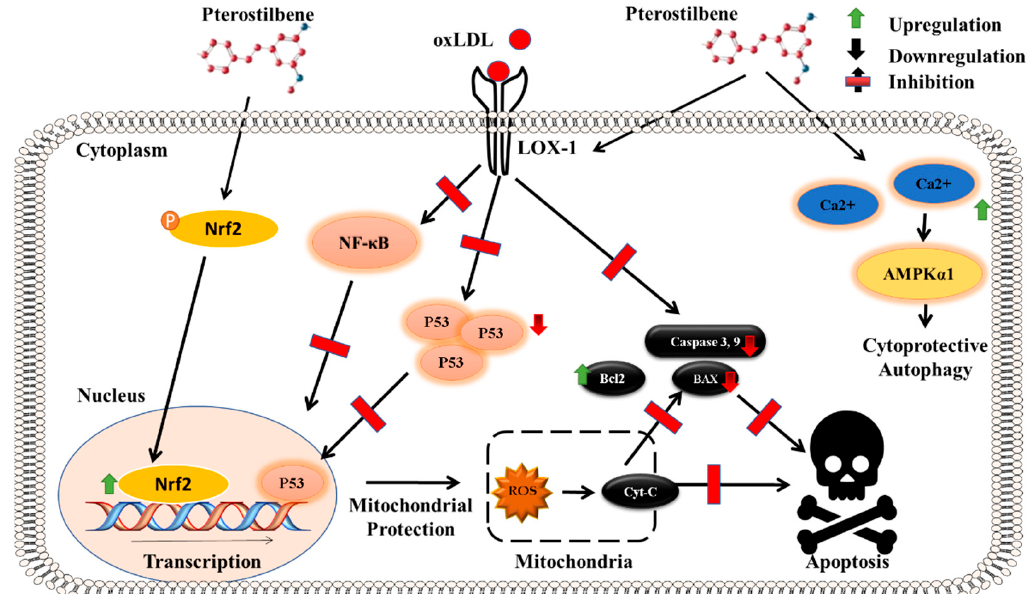
Figure 2. Anti-apoptotic pathway of pterostilbene: PTS mediates its cytoprotective effect mainly through the activation of Nrf-2, which in turn protects the mitochondrial functioning, thereby causing a reduction in the induction of pro-apoptotic factors such as cytochrome C, BAX, and caspase-3. In vascular endothelial cells, PTS protects against the initiation of apoptotic signaling by countering the effect of oxLDL in activating its receptor lectin-like oxidized low-density lipoprotein (LOX-1), thereby preventing the accumulation of P53 as well as the activation of NF κ B. Moreover, PTS increases the intracellular calcium levels and promotes the cytoprotective autophagy of the cell, consequently preventing the deleterious effect of apoptosis.